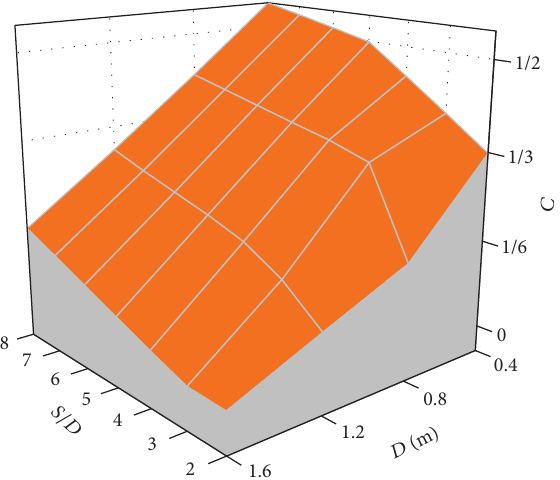
Figure 10: Variation of the 𝐶 opt with pile diameter and spacing for Model A